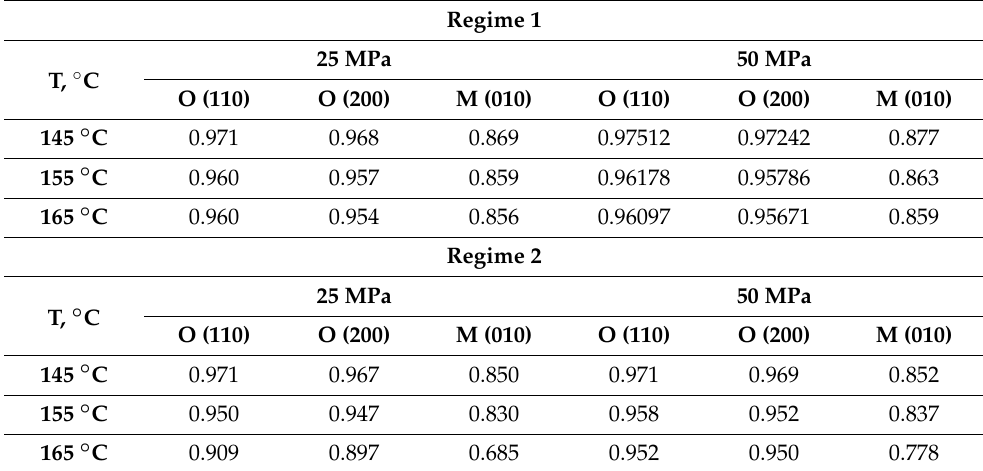
Table 1. Herman’s factor f for crystallographic planes for SRCs obtained at different conditions. Regime 1